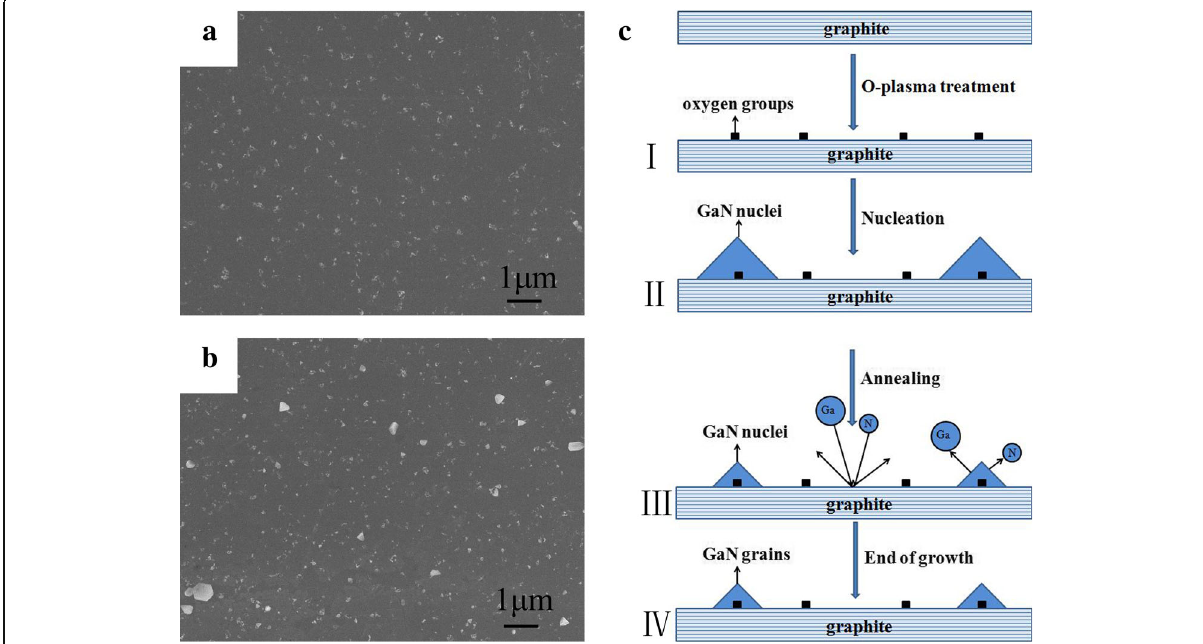
Fig. 2 a FE-SEM image of annealed islands. b The surface morphology of GaN grains at the end of growth. c Proposed schematic of growth mechanism of GaN grains